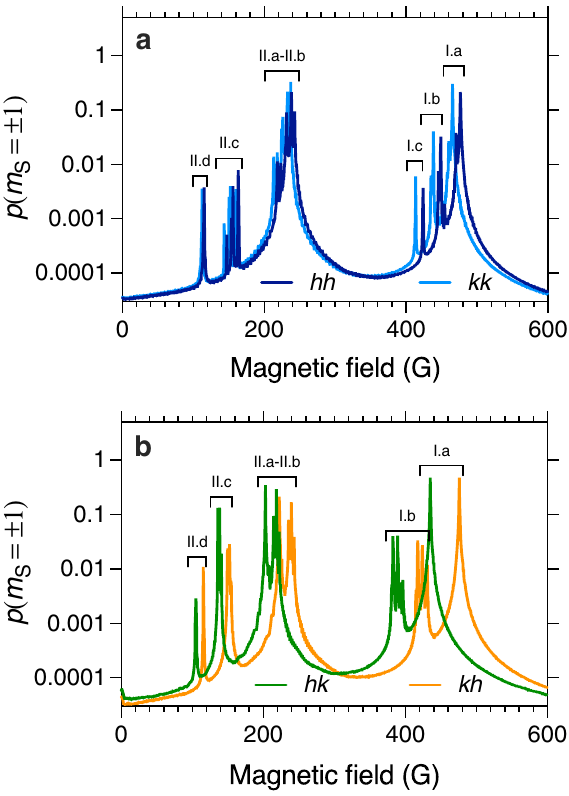
Fig. 4 Magnetic fi eld dependence of the population of the divacancy m S = ±1 spin states due to spin fl ip- fl ops induced by V1 and V2 silicon-vacancy centers. a and b depict the magnetic fi eld dependence of the spin mixing of hh and kk and hk and kh divacancy centers, respectively. In addition to the primary peaks I.a and II.a, observed for spin-1/2 defect, satellite peaks I.b, I.c, II.b, and II. c can be observed to the left of their respective primary peaks. The satellite peaks correspond to double and triple quantum jumps of environmental silicon vacancies. In a and b the magnetic fi eld is parallel to the quantization axis of the divacancy qubits in all cases. At t = 0, the central divacancy is initialized in the m S = 0 state, while the spin bath is in a high-temperature thermal state.